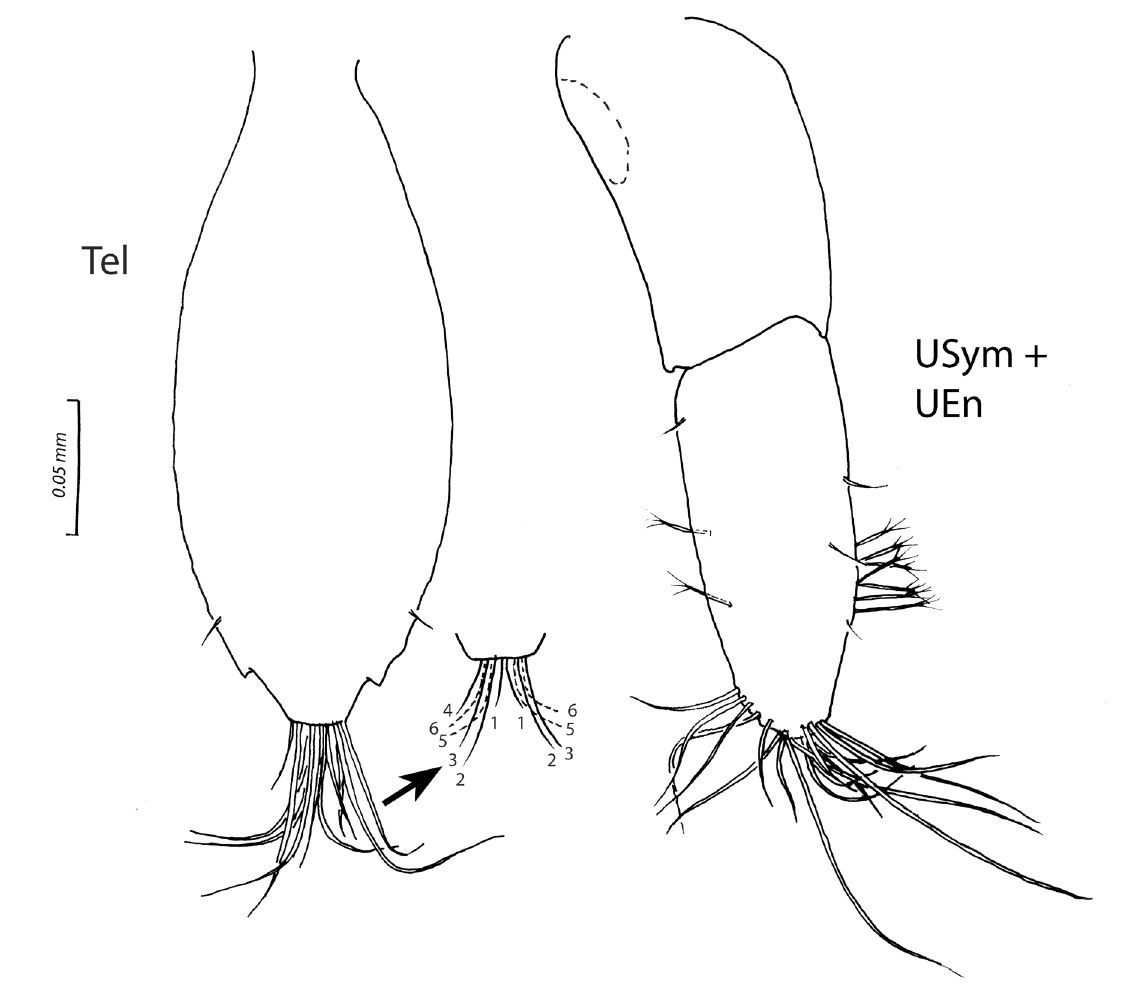
Fig. 9. Kupellonura indonesica sp. nov., holotype, immature adult (MZB Iso 100) . Abbreviations: Tel = telson; Usym = sympod of uropod; Uen = endopod of